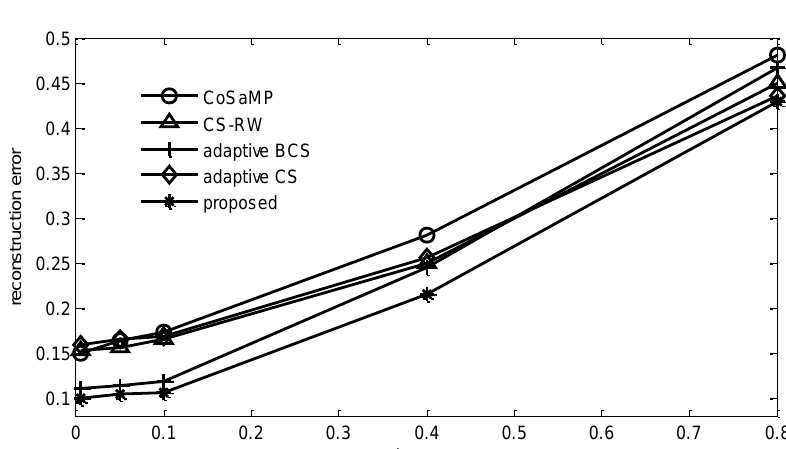
Figure 16. Impact of noise